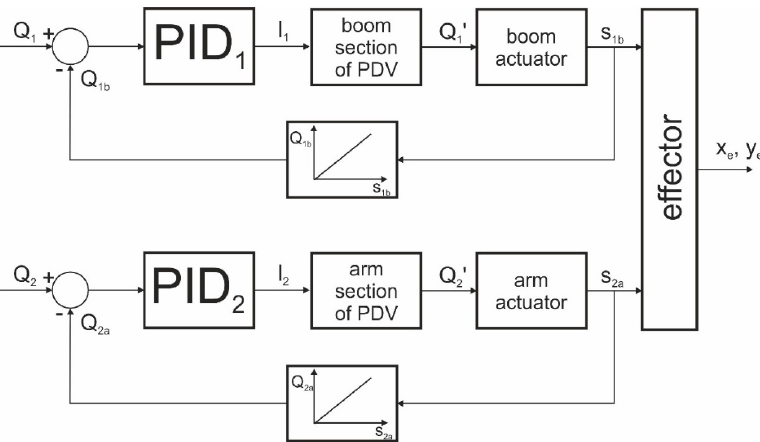
Figure 9. Control system diagram, where PID 1 is the PID controller of boom section and PID 2 is the PID controller of arm section. Table 3. Parameters of the PID controllers.